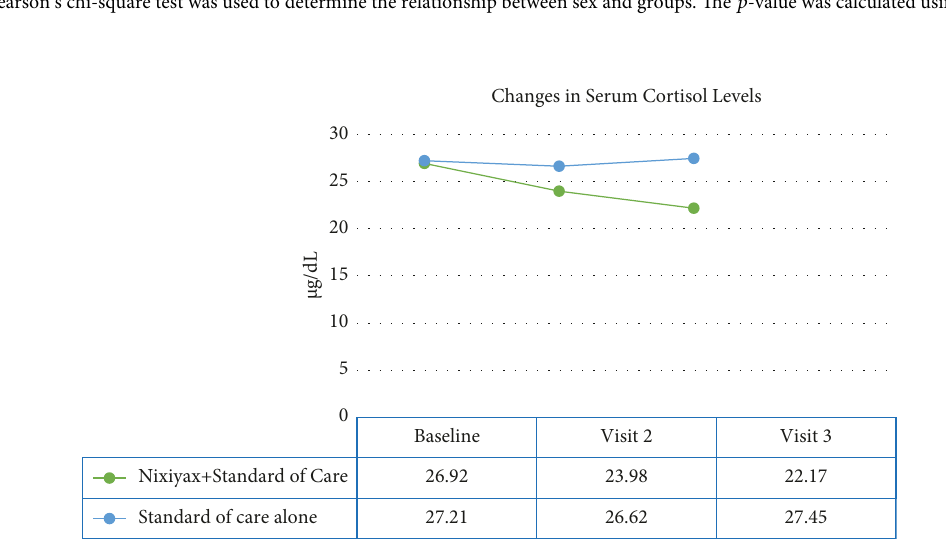
Figure 2: Average serum cortisol levels at baseline, visit 2, and visit 3. The change from baseline to visit 3 was significant in the Lactium plus standard of care group but not in the standard of care alone group.